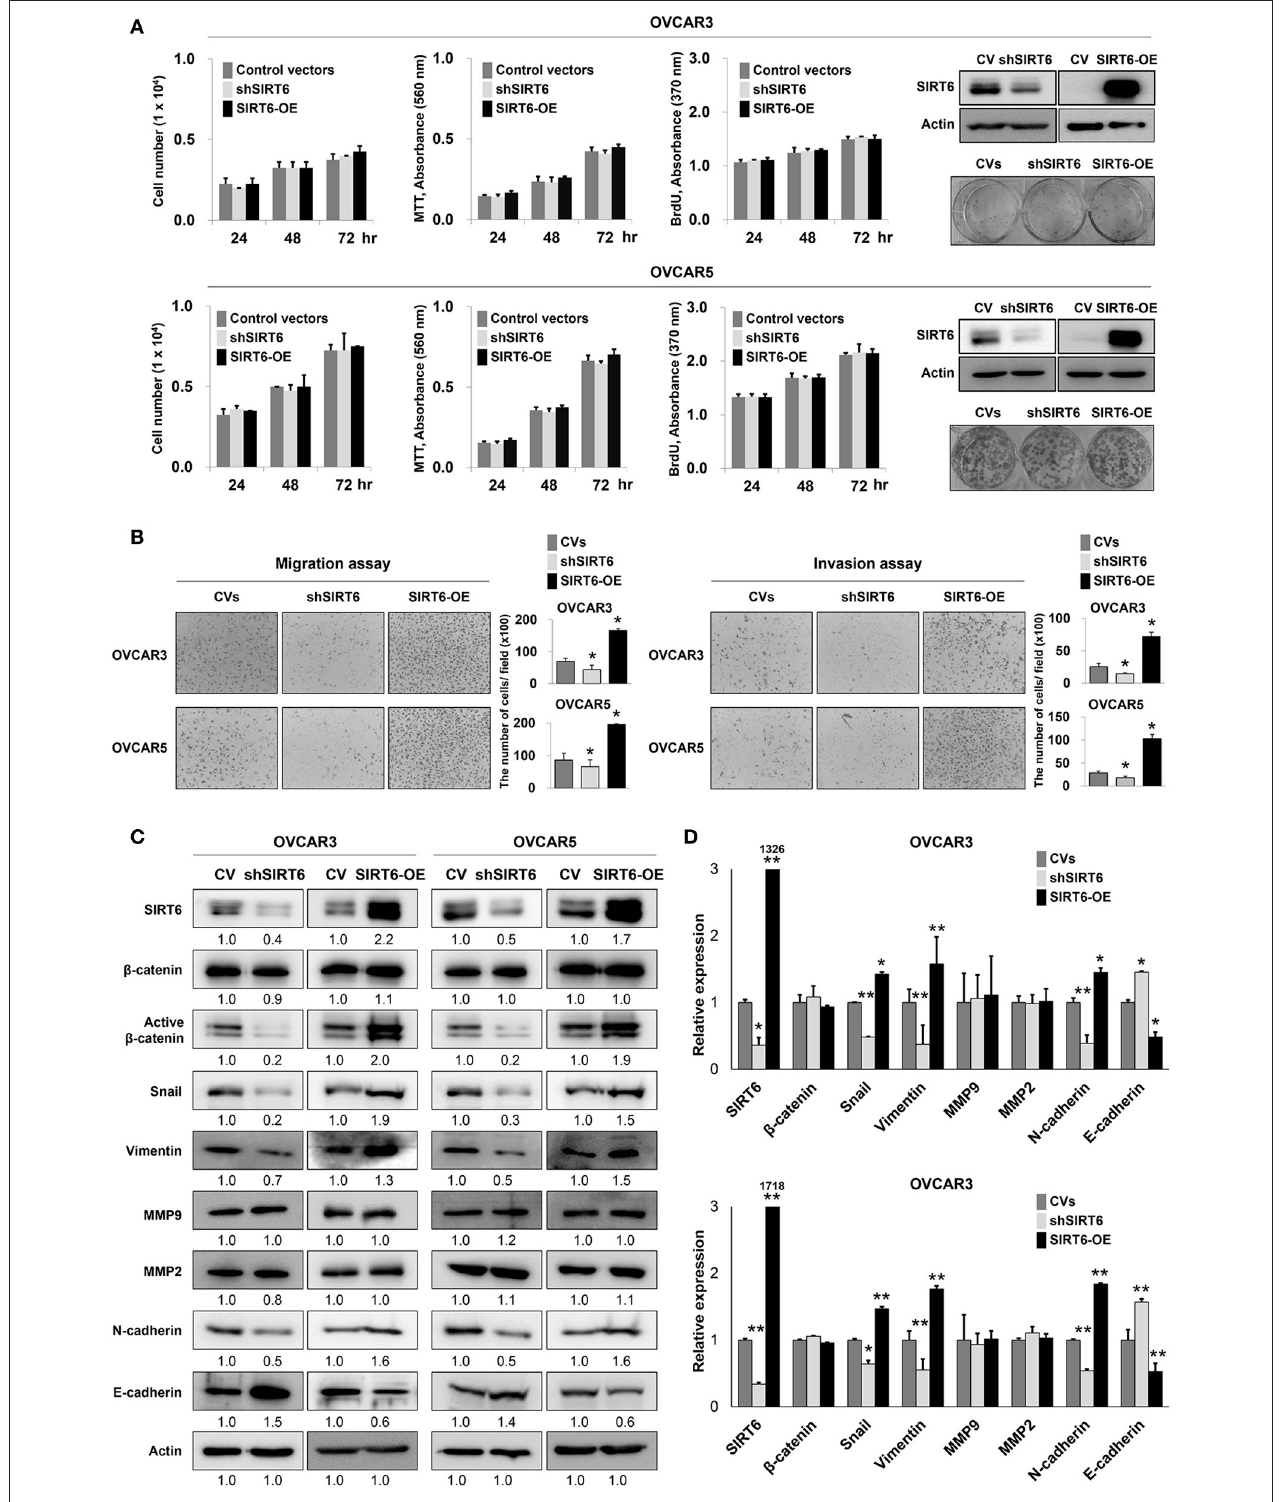
FIGURE 4 | The effect of SIRT6 on the proliferation and invasiveness of ovarian cancer cells. (A) Counting the number of cells, MTT, BrdU incorporation, and colony forming assays were performed to evaluate the proliferation of OVCAR3 and OVCAR5 ovarian cancer cells after knock-down of SIRT6 with shRNA for SIRT6 or overexpression of SIRT6 with wild-type SIRT6. Western blotting was performed to show knock-down or overexpression of SIRT6. (B) Migration and invasion assays